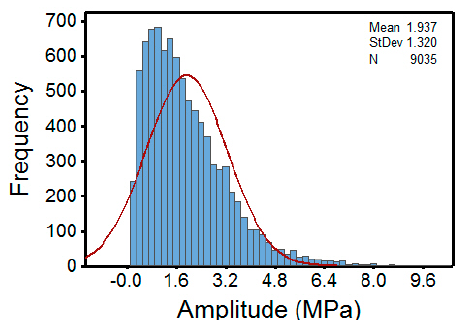
Figure 11. Histogram of the amplitude of the peak.